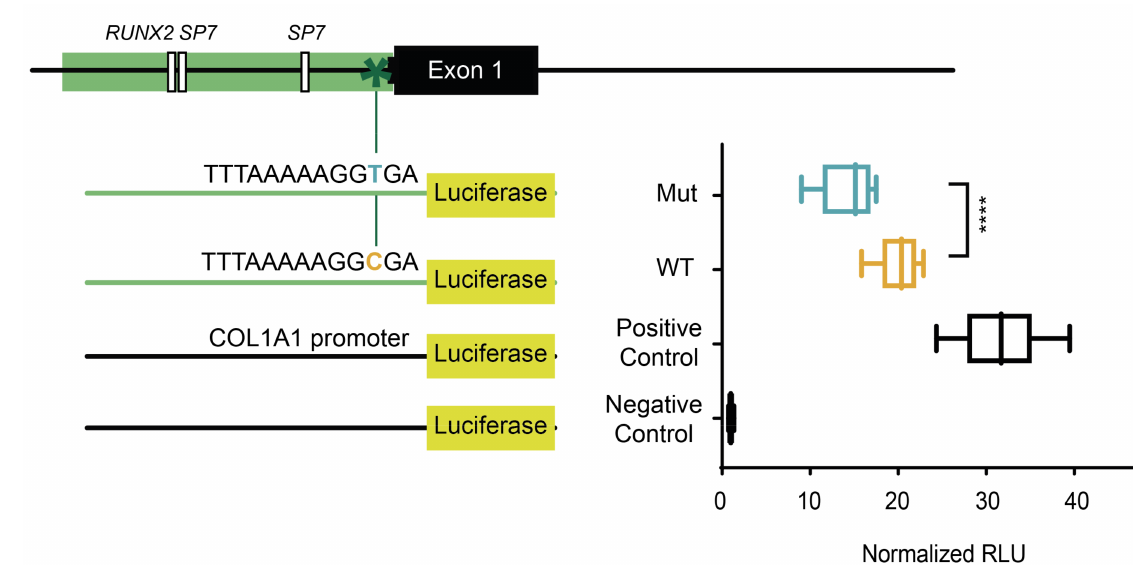
Figure 1. Functional testing of a rare variant in the extended TATA box of SOST . rs570754792 (g.41836179 G > A in GRCh37.p13) belongs to the extended TATA box of SOST , which is encoded in the negative strand of chromosome 17, thereby generating a C > T substitution. In black, a scheme of the location of the variant (asterisk) in the SOST upstream region and in green the constructs tested. We used the luciferase gene without promoter as a negative control and the COL1A1 promoter as a positive control. Relative luciferase units (RLU; see material & methods) are normalized to the negative control. The experiment was performed four times in triplicate. **** indicates p <